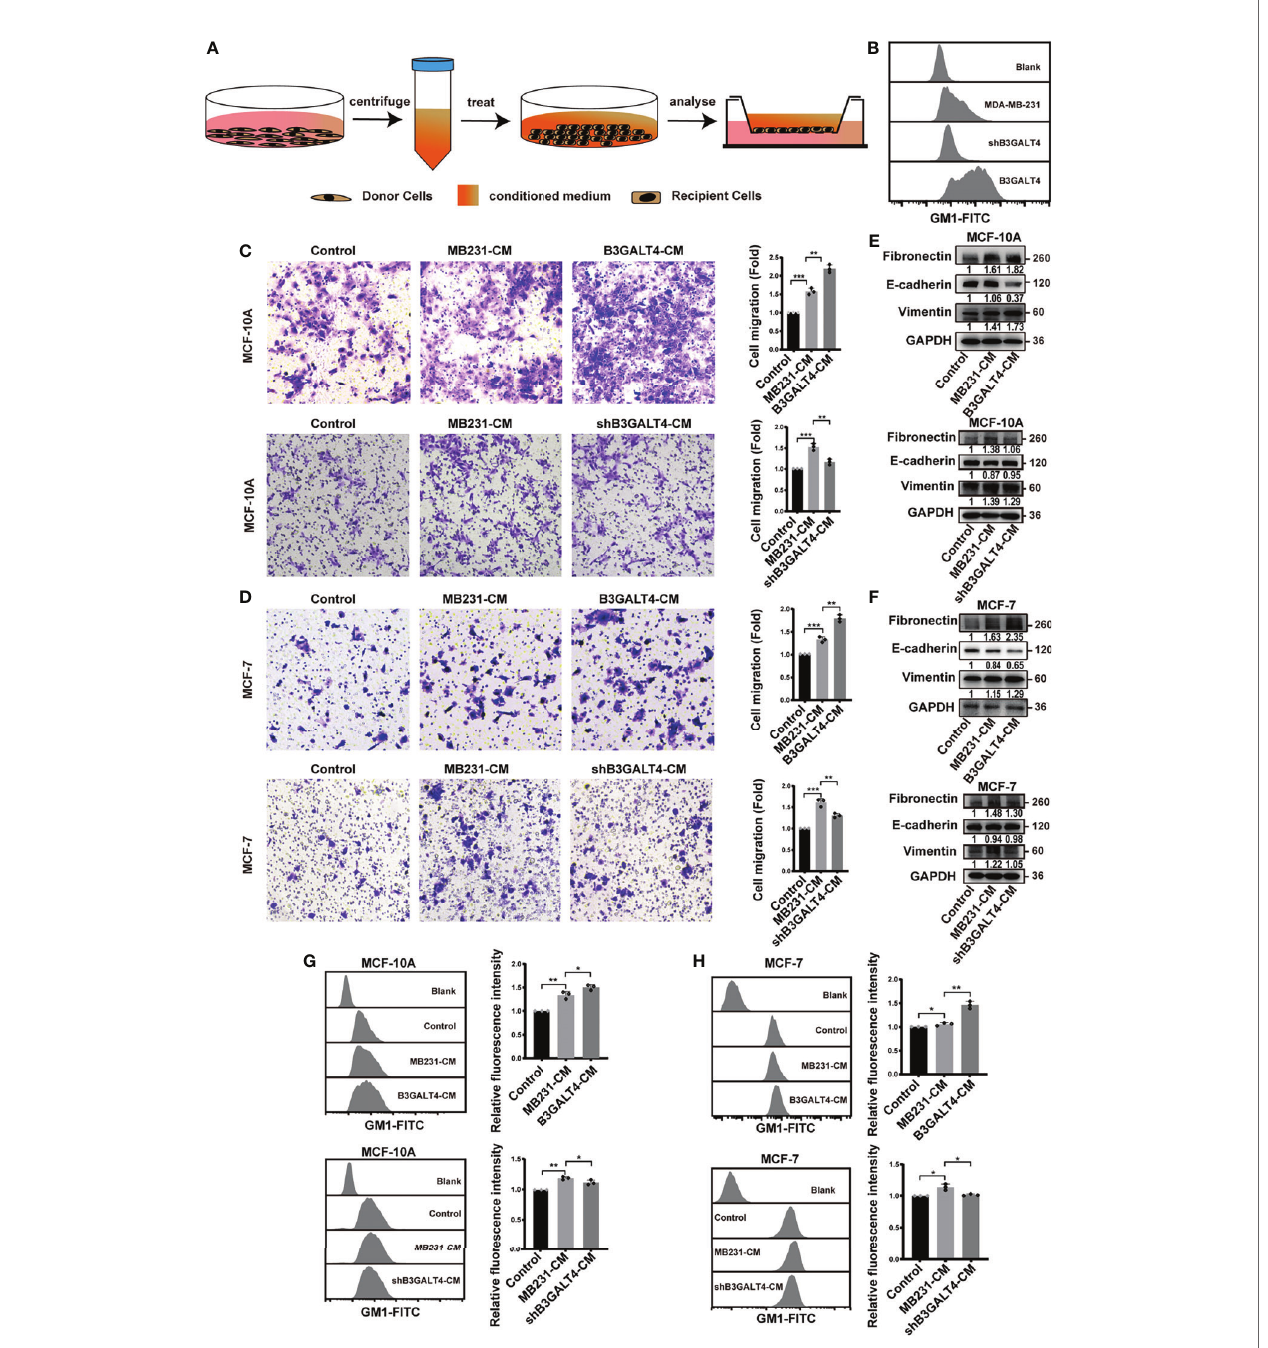
FIGURE 2 | Conditioned medium of B3GALT4-overexpressed cells affect EMT process of MCF-10A cells and MCF-7. (A) Schematic model of conditioned medium treatment. Conditioned medium was collected as described in Materials and Methods. Recipient cells were incubated with CM, and then subjected to transwell assay, Western blot, and fl ow cytometry analysis. (B) GM1 levels in parental, B3GALT4-overexpressed and -silenced MDA-MB-231 cells were determined by fl ow cytometry. B3GALT4, B3GALT4- overexpressed MDA-MB-231 cells, shB3GALT4, B3GALT4-silenced cells. Blank indicates unstained MDA-MB-231 cells. MDA-MB-231, shB3GALT4, and B3GALT4 indicate parental, B3GALT4-silenced, and B3GALT4-overexpressed MDA-MB-231 cells stained with CTB-Biotin. (C, D) The migratory ability of MCF-10A (C) and MCF-7 cells (D) treated with B3GALT4-CM and shB3GALT4-CM. (E, F) The expression of fi bronectin, E-cadherin, and vimentin in MCF-10A (E) and MCF-7 cells (F) treated with B3GALT4-CM and shB3GALT4-CM, evaluated by Western blot. (G, H) GM1 levels in MCF-10A (G) and MCF-7 cells (H) treated with B3GALT4-CM and shB3GALT4-CM, evaluated by fl ow cytometry. Blank indicates unstained MCF-10A or MCF-7 cells. Control indicates recipient cells stained with CTB-Biotin. MB231-CM, B3GALT4-CM, and shB3GALT4-CM indicate recipient cells with the corresponding CM treatment stained with CTB-Biotin. The above experiments were performed in triplicate wells and independently conducted three times. * p < 0.05, ** p < 0.01, *** p <